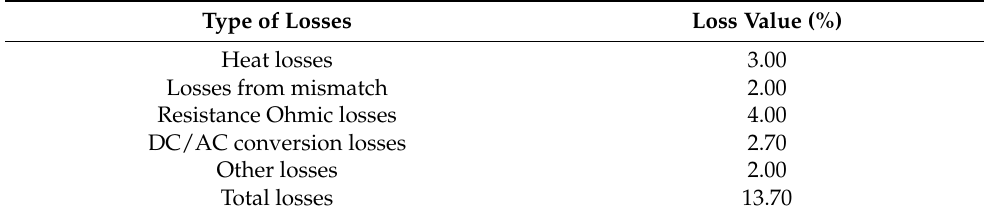
Table 1. Losses in the analysed photovoltaic installation.